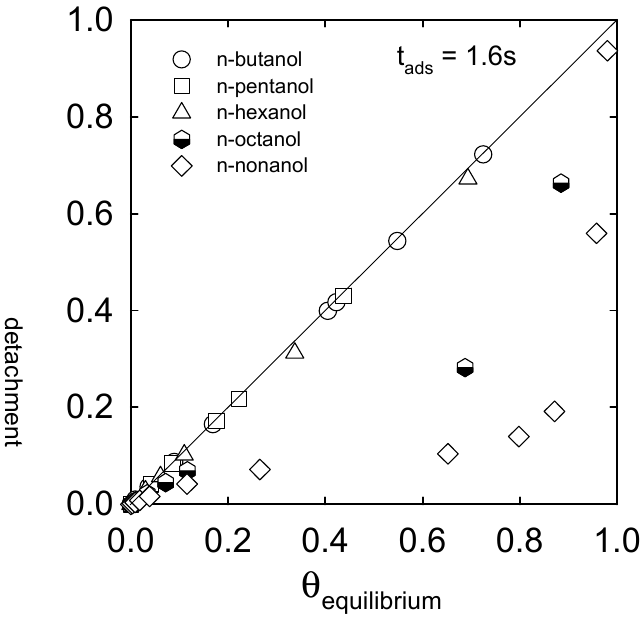
Figure 7. The adsorption coverage over the surface of the departing bubble (t ads = 1.6 s) as a function of the equilibrium adsorption coverage.